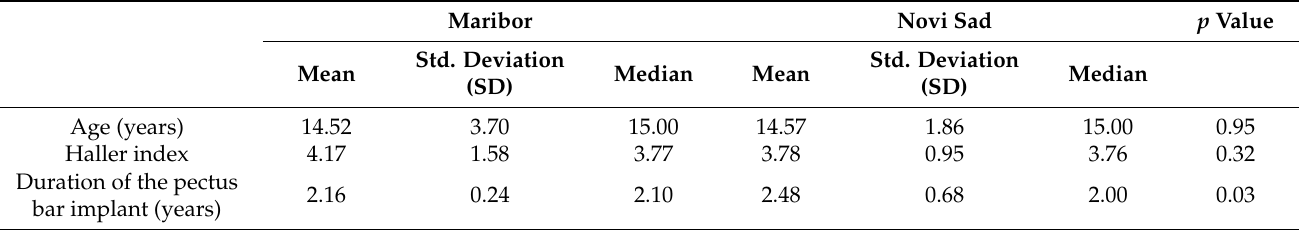
Table 1. Frequency values for age, the CT Haller index and duration of the pectus bar implant in Maribor (Mb) and Novi Sad